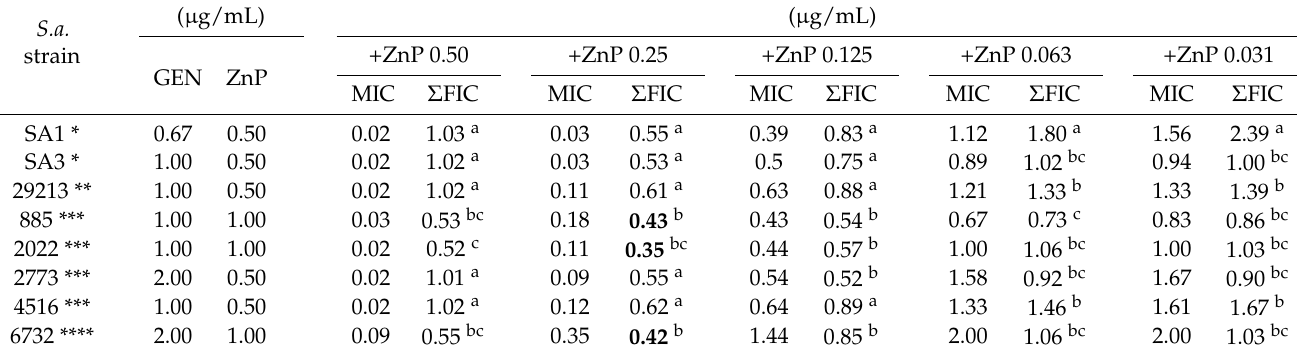
Table 3. In vitro inhibitory activity of zinc pyrithione/gentamicin combinations against Staphylococcus aureus strains.